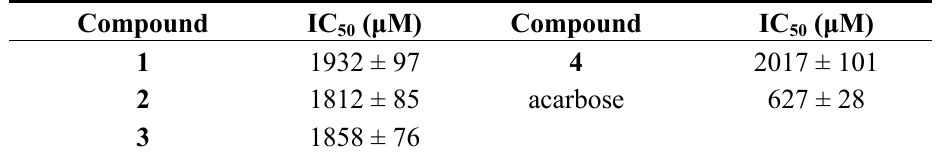
Table 2. Inhibitory effects of compounds 1 – 4 and acarbose against α -glucosidase a,b